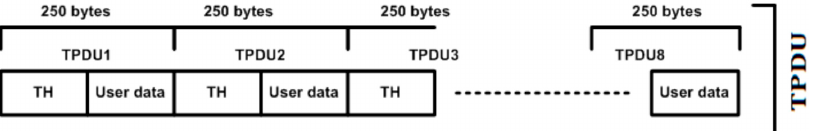
Figure 5. Multiple TPDU blocks.